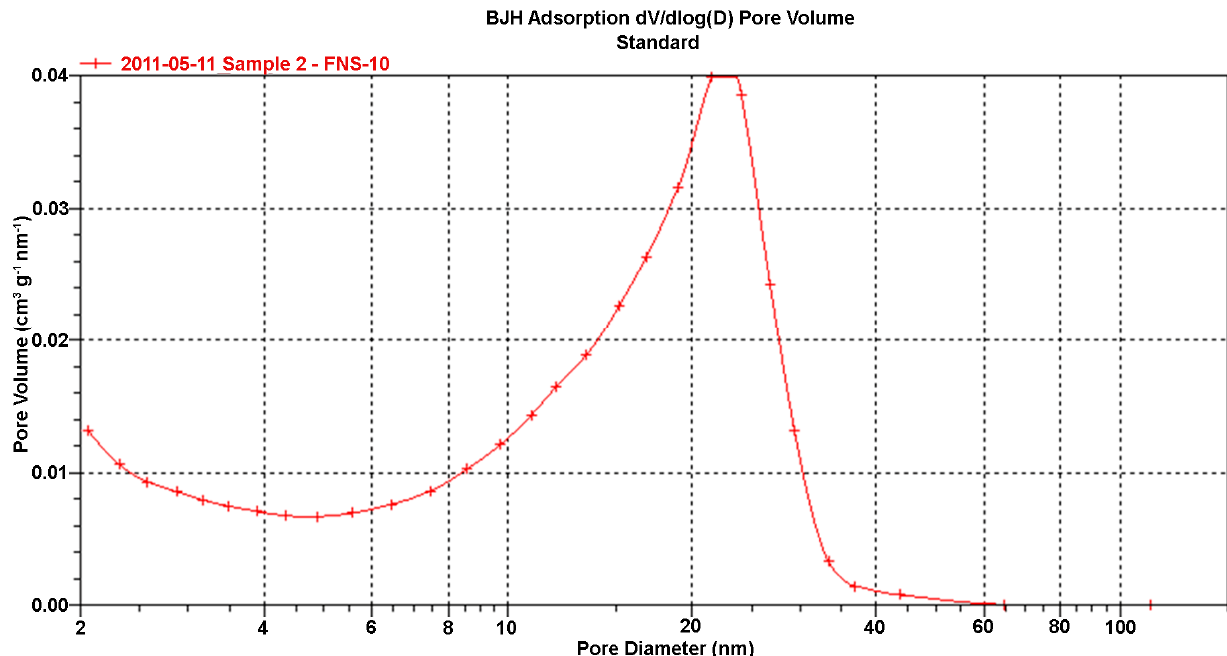
Figure 6. BJH pore size distribution of FNS sorbent. X -axis is the pore diameter, nm; Y -axis is the volume of pores of a specific diameter, cm 3 g –1 of the sorbent.